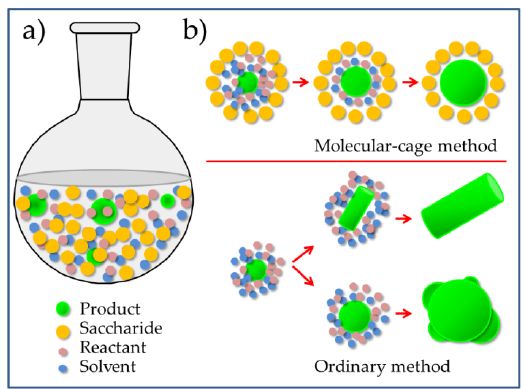
Figure 2. ( a ) Scheme showing the molecular cage system; ( b ) comparison between molecular-cage and ordinary method. Adapted from [34], American Chemical Society, 2016.